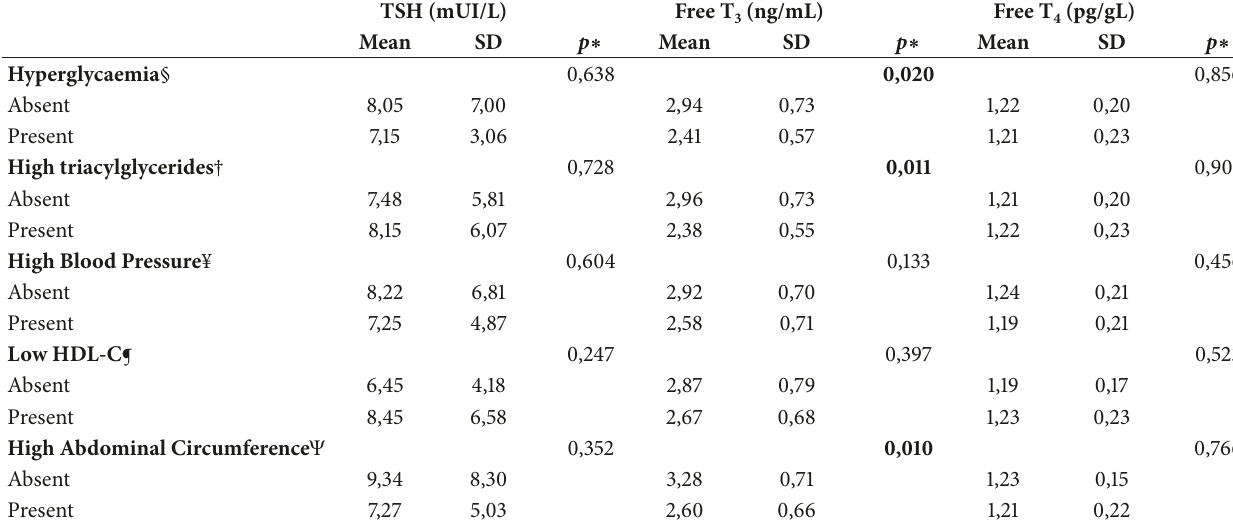
Table 3: Thyroid hormones and metabolic syndrome components in adults from Maracaibo City, Venezuela.